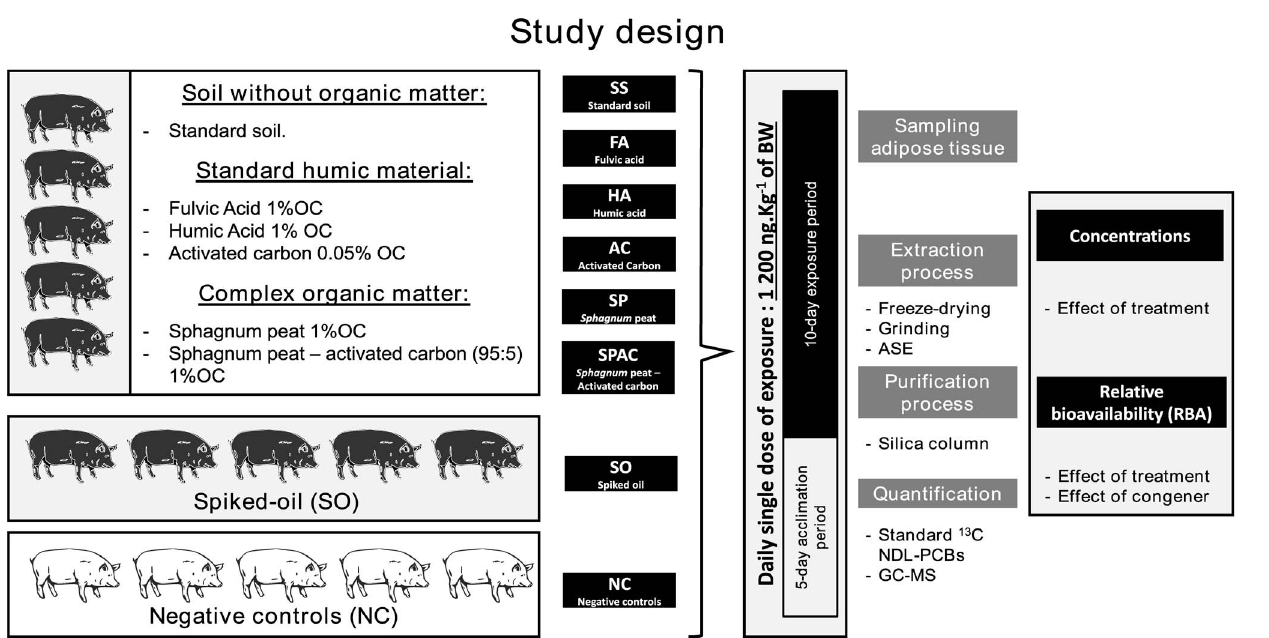
Fig. 1. Animal management and experimental design of the study.